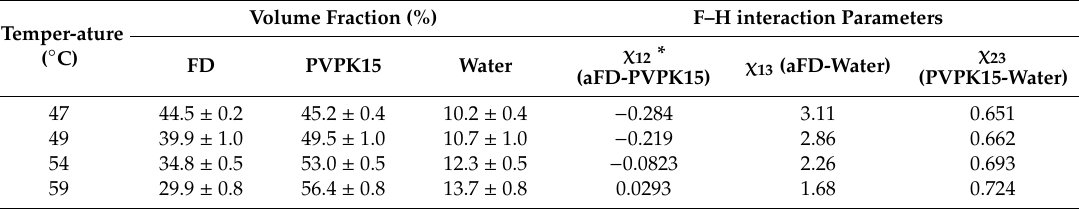
Table 3. Data of F − H interaction parameter χ and volume fraction of drug, water, and polymer ternary system at the AAPS boundaries conditions ( n = 3).